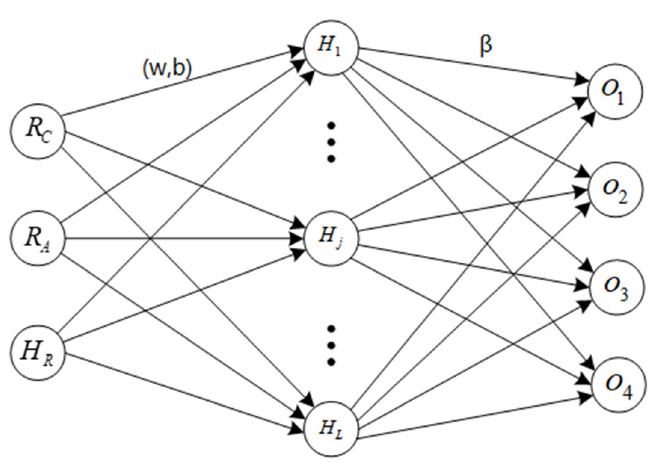
Figure 6. Extreme learning machine (ELM) model based on fatigue driving detection.